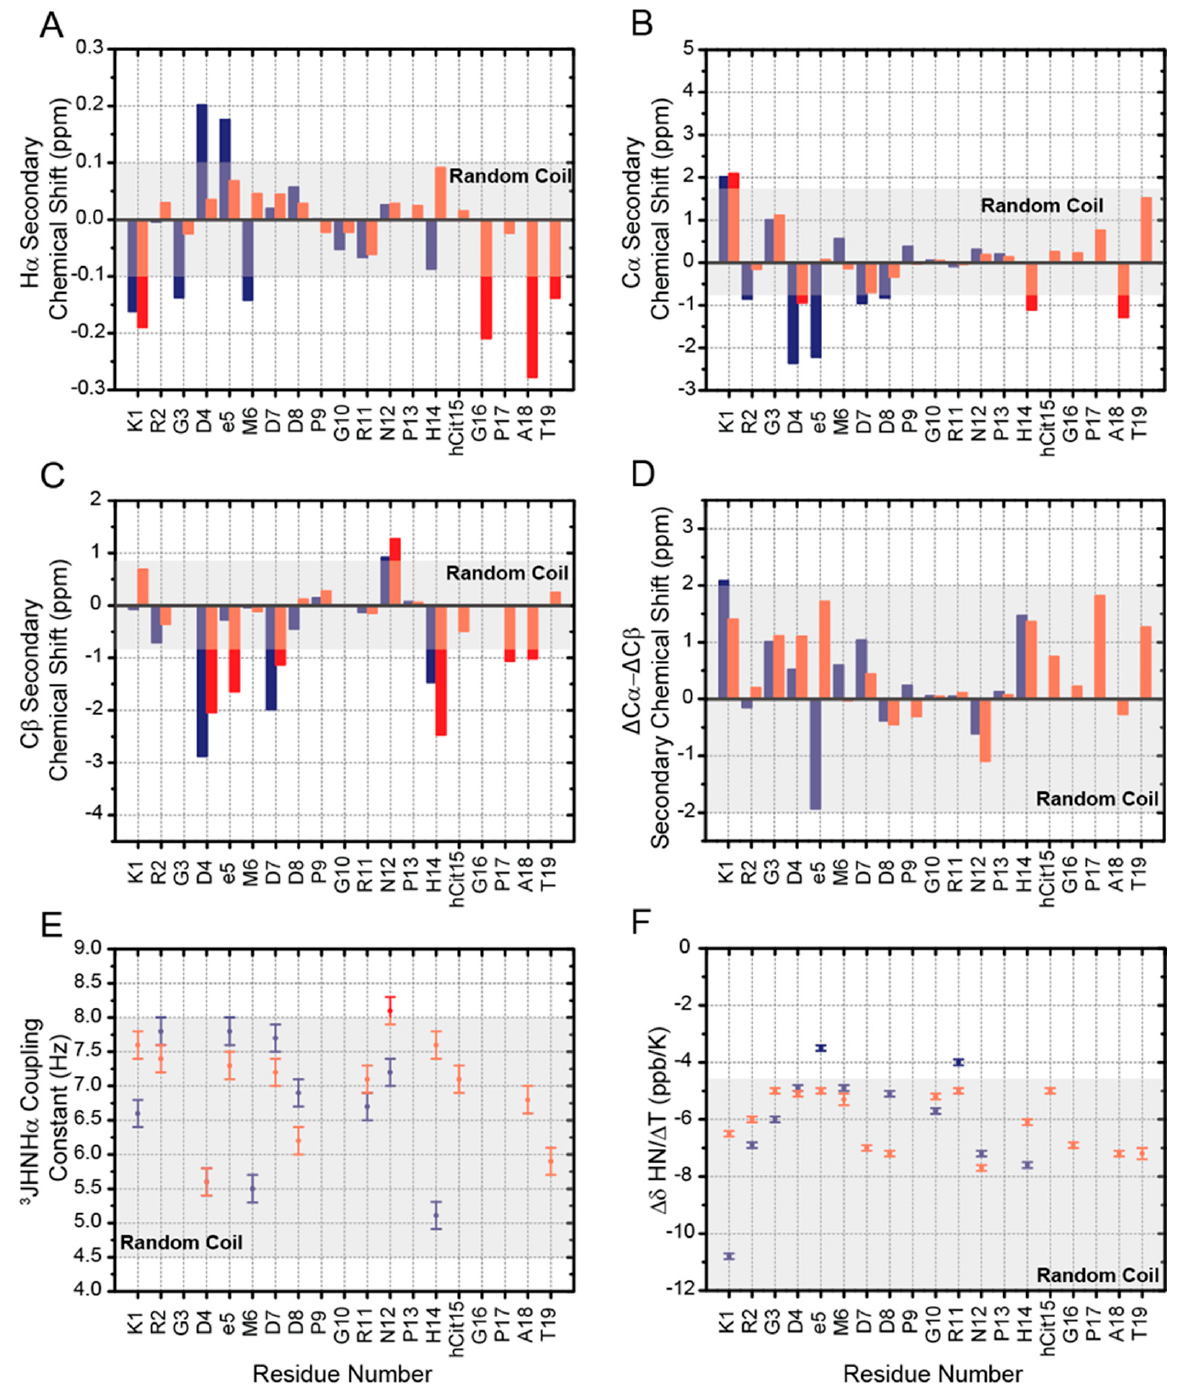
Figure 3 . Secondary structure propensity of RGDechi1-14 and ψ RGDechi. H α ( A ), C α ( B ) and C β ( C ) secondary chemical shifts analysis of RGDechi1-14 (blue) and ψ RGDechi (red). The per-residue Δδ C α−Δδ C β difference ( D ) for both peptides is also reported. The light grey rectangles in the A–D panels indicate the cut-off values for secondary structures identification as proposed by Wishart and Marsh (see materials and methods). ( E ) 3 JHNH α coupling constants measured for RGDechi1-14 (blue) and ψ RGDechi (red). Random coil values are also reported (light grey rectangle) ( F ) Amide temperature coefficients ( Δδ HN/ Δ T) versus the residue number for RGDechi1-14 (blue) and ψ RGDechi (red). The light grey rectangle indicates values below the − 4.6 ppb/K (light grey) that are consistent with the absence of amide proton hydrogen bonding. In the panels E and F, the error bars are also included.